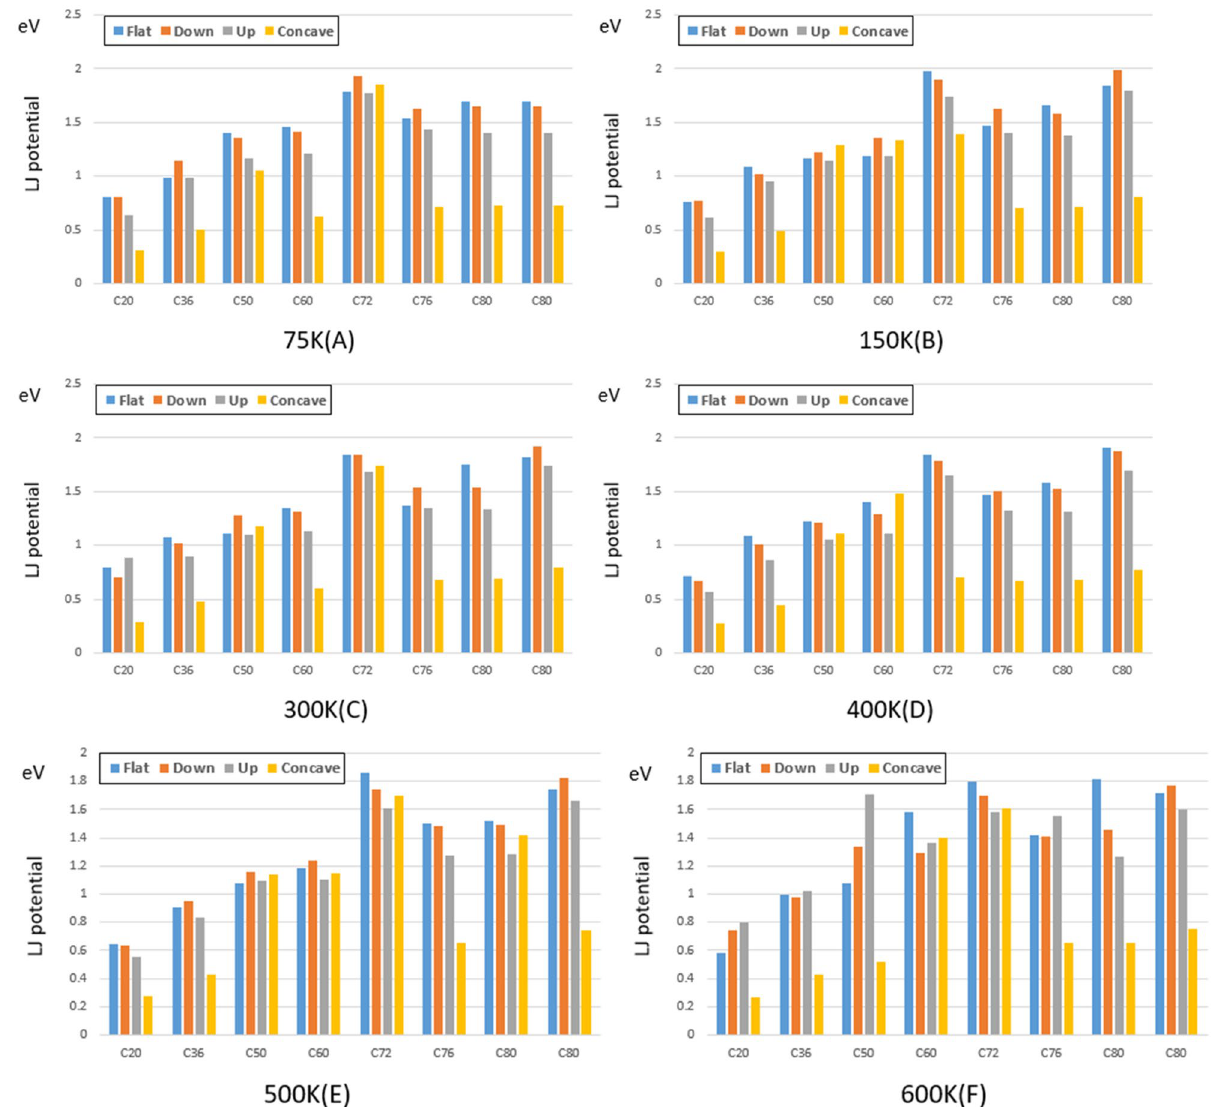
Figure 10. Lenard Jones potential energy for different fullerene molecules on a gold substrate for 75 K ( A ), 150 K ( B ), 300 K ( C ), 400 K ( D ), 500 K ( E ), and 600 K ( F ). The blue, red, black and yellow bars show Lenard Jones potential energy of the molecules on the flat, down side of the step, top side of the step, and concave substrates,